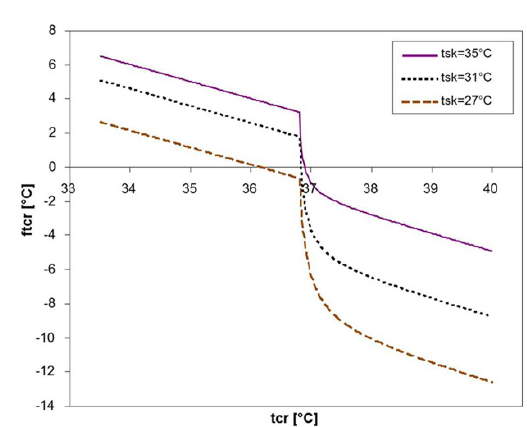
Figure 1. Roots of the body core temperature for different skin